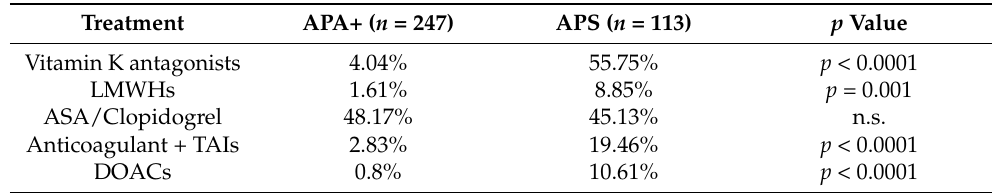
Table 3. Administration of anticoagulant and antiplatelet therapies in the groups of APA positive lupus patients without APS and secondary APS